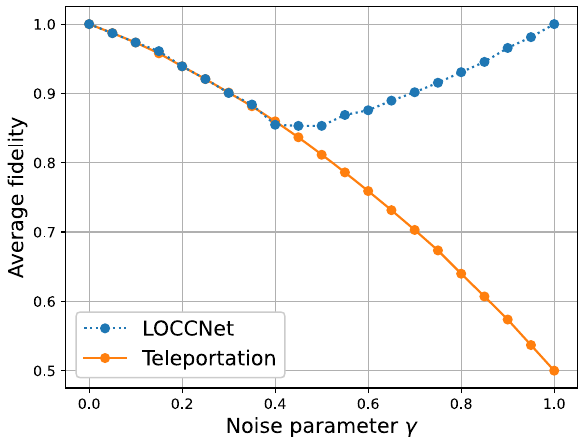
Fig. 8 Average fi delity of simulating AD channel with LOCC protocols. The blue curve depicts the behavior of the protocol via LOCCNet, which outperforms the original teleportation (orange) at high noise level (noise parameter γ > 0.4). Each data point contains the statistical results of 1000 randomly generated